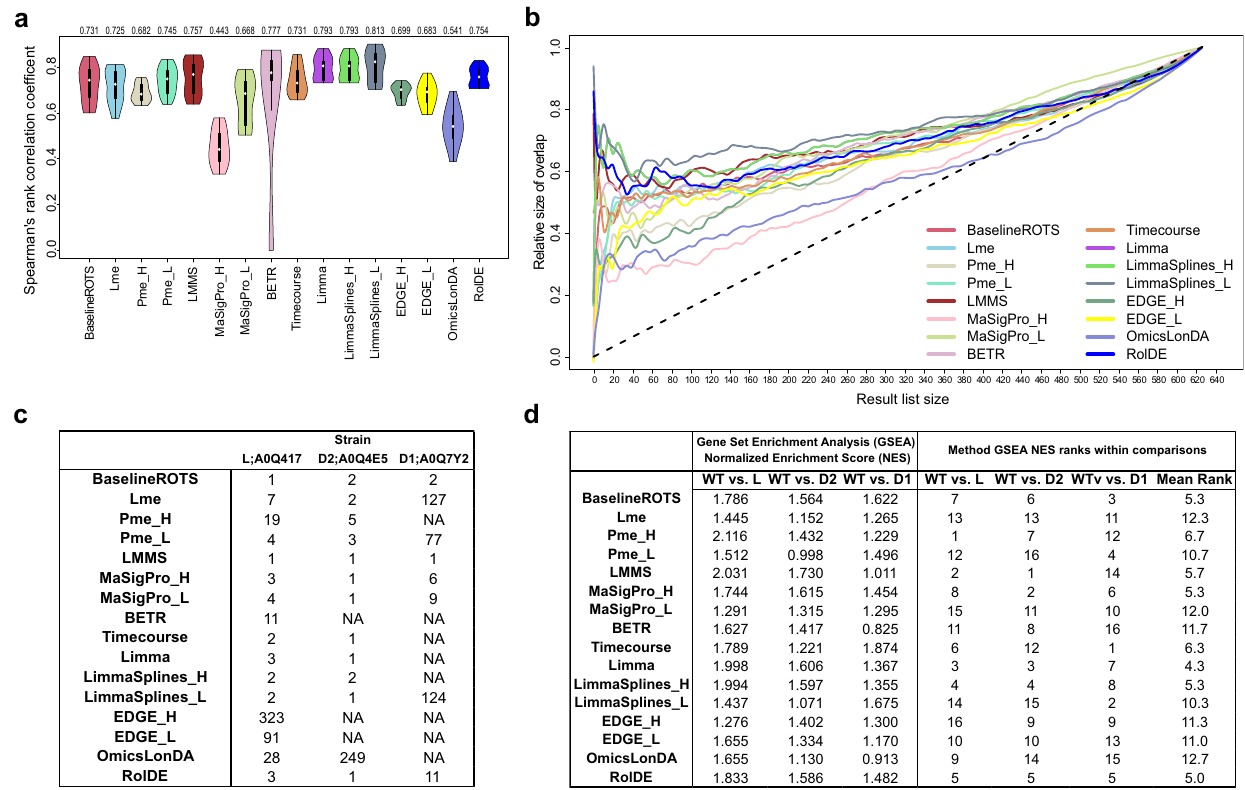
Fig. 3 | Reproducibility and biological relevance of the examined longitudinal differential expression methods in the experimental Francisella tularensis subspecies novicida (Fn) proteomics data. a Reproducibility of the methods was evaluated using the Spearman ’ s rank correlation coef fi cient between technical replicate result lists ( n =18 correlations for each method over all the six possible pairwise comparisonsofstrainswith three technicalrepeats for eachcomparison). The violin plotsdisplay the distribution of correlations for each method,including median(whitecircle),interquartilerange(IQR)fromthe fi rsttothirdquartile(black box), and 1.5* IQR (whiskers). The IQR mean of the correlations for each method is shown above each violin. Each method is shown with a unique color. b Median proportional overlaps of the top k fi ndings between the technical replicate result lists when k was varied from 1 to the length of the entire dataset. Proteins with missingvalueswere fi lteredoutfromthedatasetpriortothereproducibilitytesting